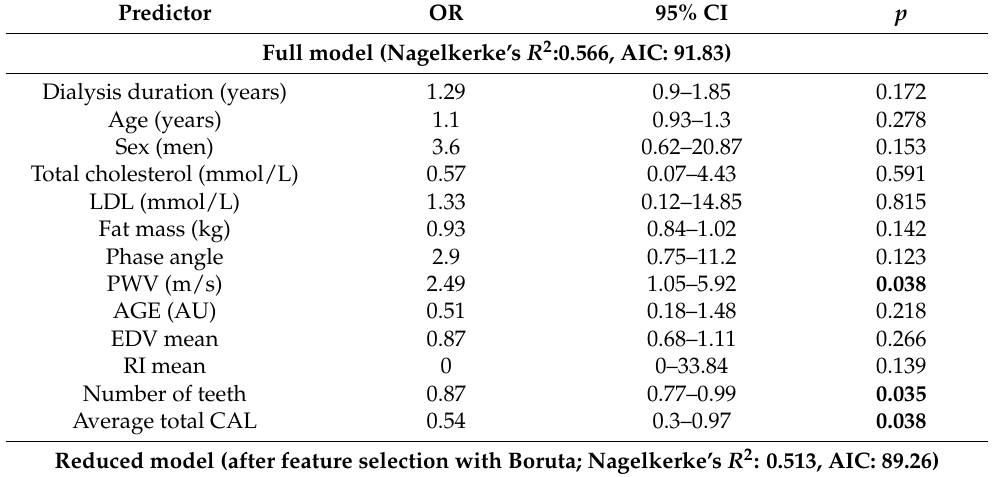
Table 2. Multivariate logistic regression for identification of predictors for atherosclerosis in KTRs. Predictor